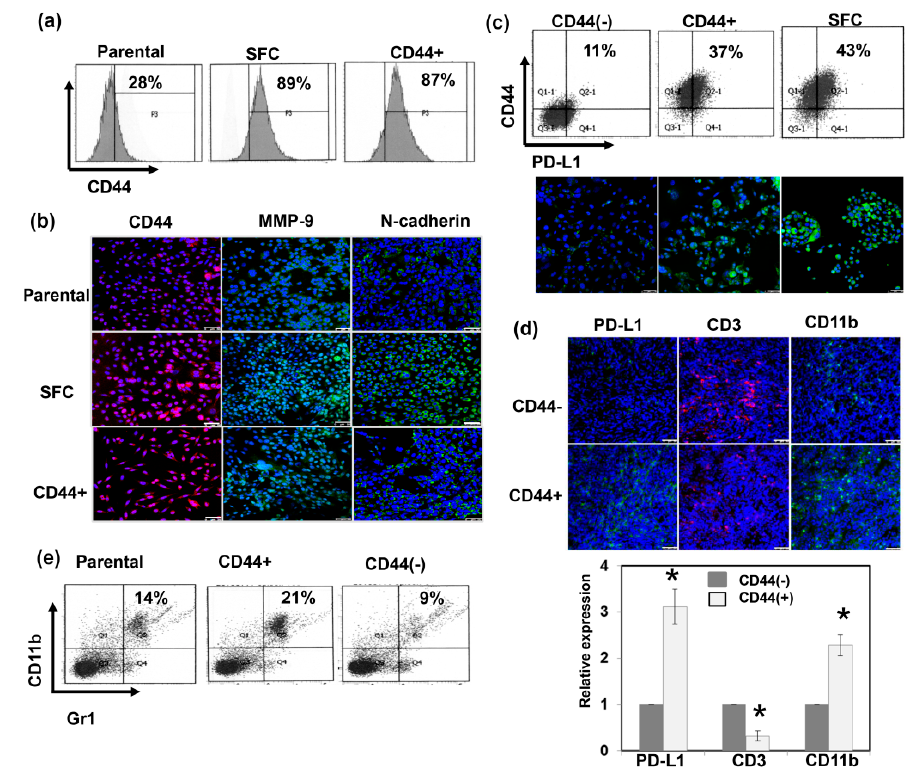
Figure 4. The expression of CD44 is correlated with CSC and PD-L1 expression. ( a ) The levels of CD44 were evaluated by FACS for sphere-forming cells (SFCs) and CD44 + cells compared with parental cells in vitro. ( b ) Expressions of EMT-related proteins were examined by IF in vitro. (DAPI, blue; N-cadherin / MMP-9, green; CD44, red). Scale bars: 50 µ m. ( c ) The levels of PD-L1 were evaluated for SFCs and CD44 + cells compared with CD44- cells by FACS and IF in vitro (DAPI, blue; PD-L1, green). Scale bars: 50 µ m. CD44 + cancer cells were associated with increased myeloid-derived suppressor cells (MDSC) recruitment and attenuated infiltration of CD3 + T cells in tumors by ( d ) IF (DAPI, blue; CD3, Red; PD-L1 / CD11b, green) with Scale bars: 50 µ m, and ( e ) FACS (CD11b +/ Gr1 + cells) in vivo. The quantification is to calculate the value of the cell number positive for targeted protein divided by the total cell number. The Y -axis represents the ratio normalized by the value of CD44 ( − ) cells. *, p <